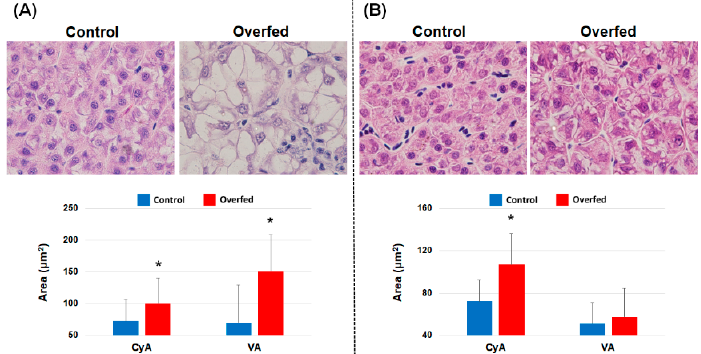
Figure 2. Liver histology results. Panels ( A , B ) represent samples taken at weeks 2 and 8, respectively. The bar plots indicate the cytoplasmic area (CyA) and vacuolated area (VA) in the hepatocytes. The results are presented as the mean ± S.D. * indicates a significant difference ( p < 0.05 based on student’s t -test).